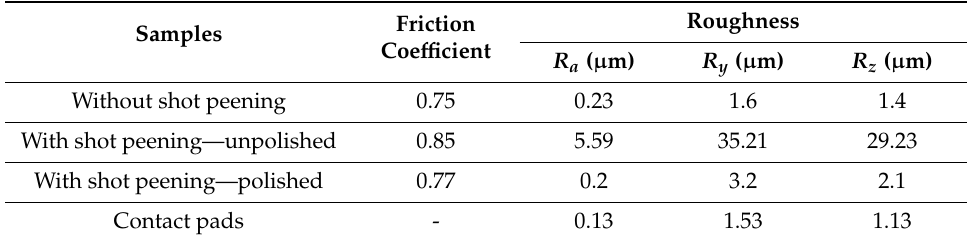
Table 6. Surface roughness and friction coe ffi cient for specimens under di ff erent treatments and contact pads.